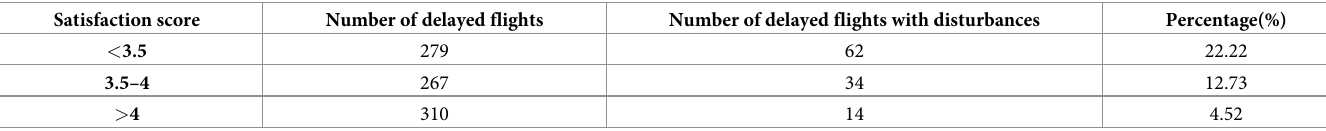
Table 4. Delayed flights and satisfaction evaluation scores of different airlines at Shenzhen Airport, 2018. Satisfaction score